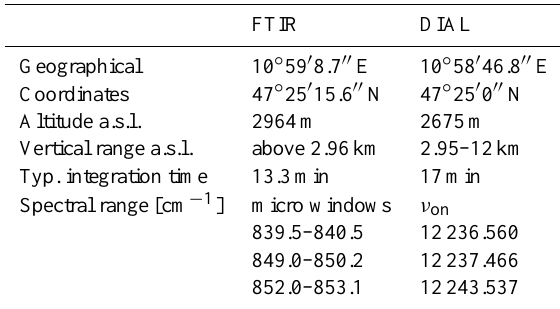
Table 1. Specifications of the FTIR and the DIAL on the Zugspitze.